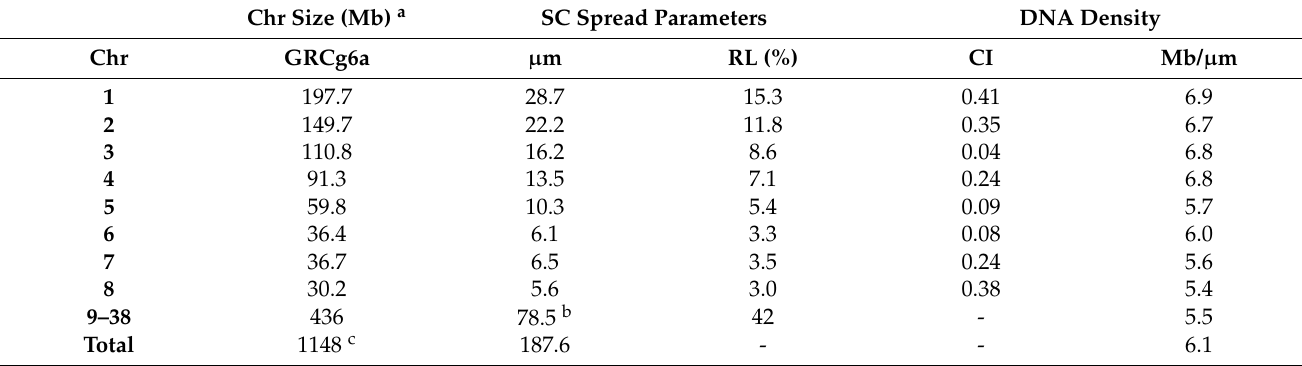
Table 1. SC lengths, chromosome sizes and DNA density in Gallus domesticus